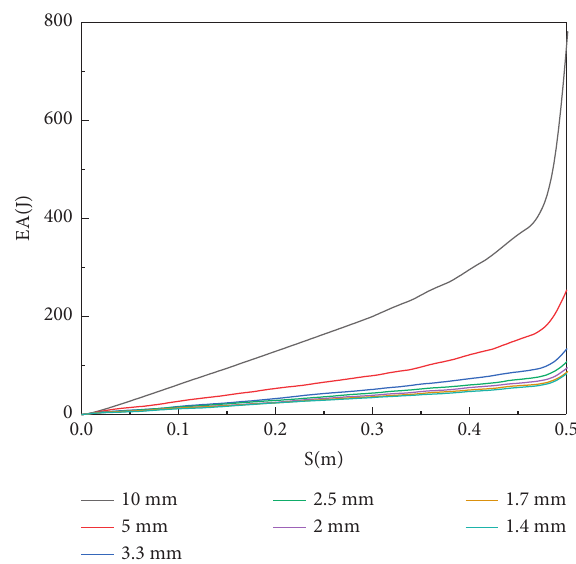
Figure 2: Convergence analysis of element size of the